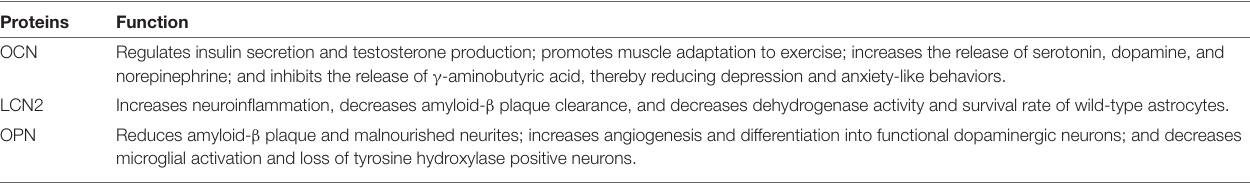
TABLE 1 | Bone-derived proteins involved in brain disorders. Proteins